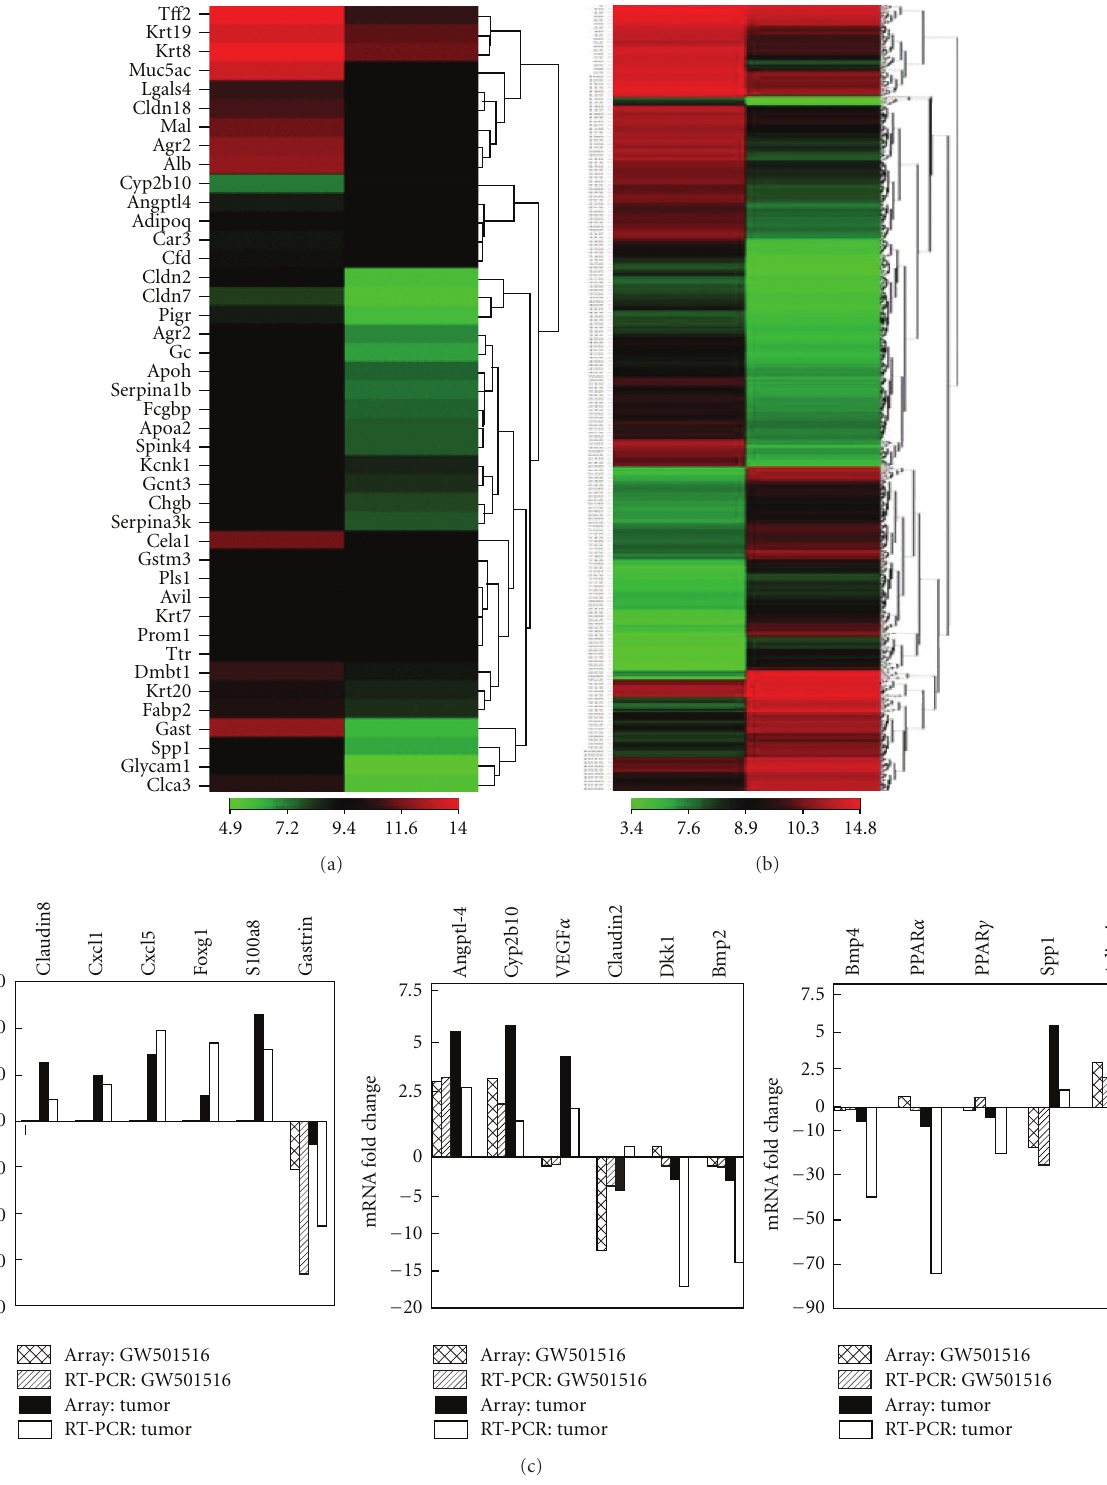
Figure 3: Di ff erential gene expression in GW501516-treated stomach and gastric tumors. Gene microarray analysis was carried out with pooled RNA samples prepared from either five tissue samples of forestomach from untreated and GW501516 treated mice or six gastric tumors. Heat maps represent unsupervised hierarchical clustering of ≥ 3-fold changes in signal intensity normalized to untreated forestomach. (a) Heatmap of GW501516-treated versus stomach representing 42 genes. (b) Tumor versus stomach representing 811 genes. (c) qRT-PCR analysis of the relative changes in gene expression in the stomach after GW501516 treatment ( GW501516 ), and in tumors ( Tumor ). GW501516 treated: array, cross-hatch ; qRT-PCR, diagonal; Tumors: array, black ; qRT-PCR, white